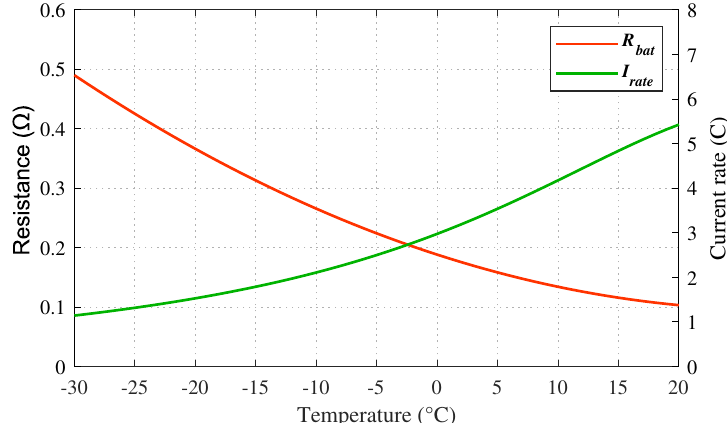
Figure 6. Internal resistance and maximum discharge rate while maintaining V bat = 2.8V for a single Li-ion 18650 cell at different cell temperatures.